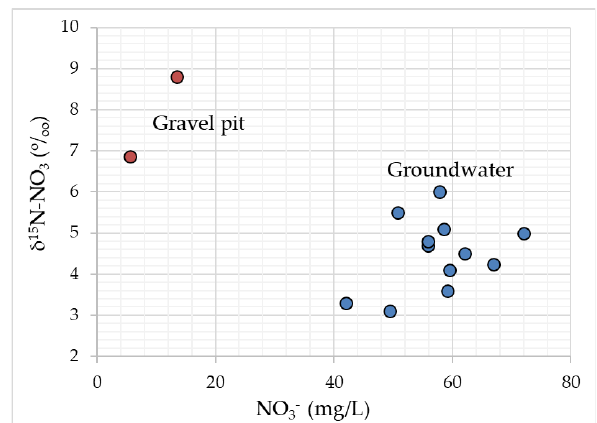
Figure 4. Relationship between the nitrate concentration and nitrate isotopic composition ( δ 15 N- NO 3 ) of the inactive gravel pit and nearby groundwater (values for groundwater are interpreted in Marković et al. [16]).